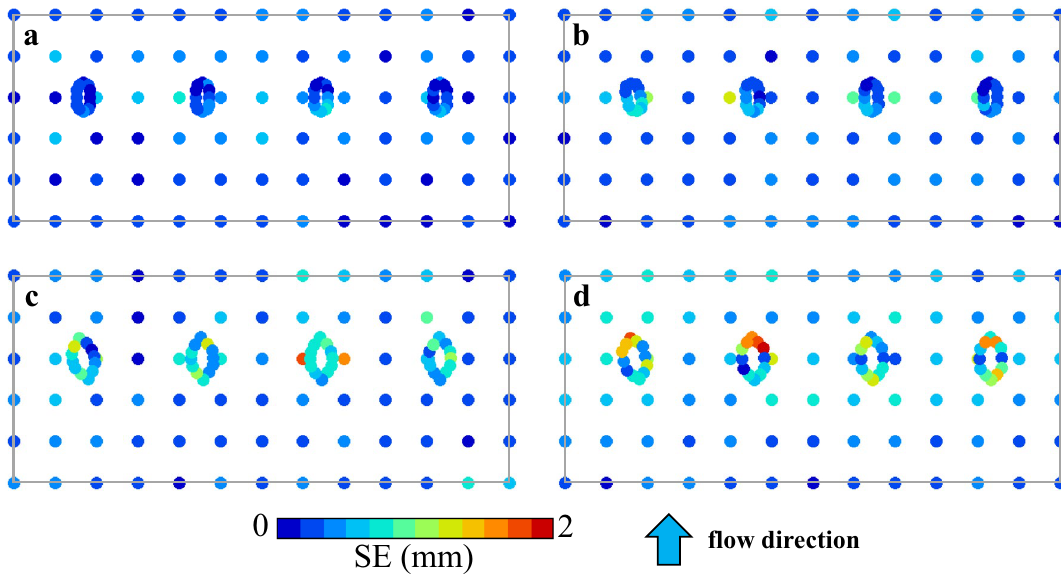
Figure 11. Spatial distributions of SE (standard error) for the five experiments at measurement points for sand layer thickness and scouring. Maximum scour (mm)* Maximum sedimentation (mm)* Pier geometry Each expt. Mean (SE) [95% CI] Each expt. Mean (SE) [95%